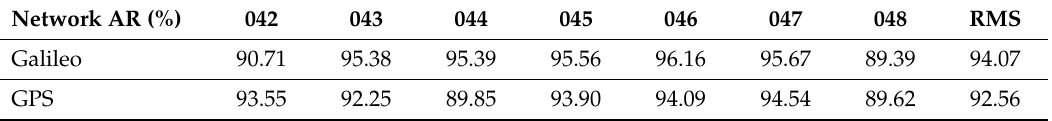
Table 7. Ambiguity resolution percentages for Galileo and GPS system for BRUX station. Network AR